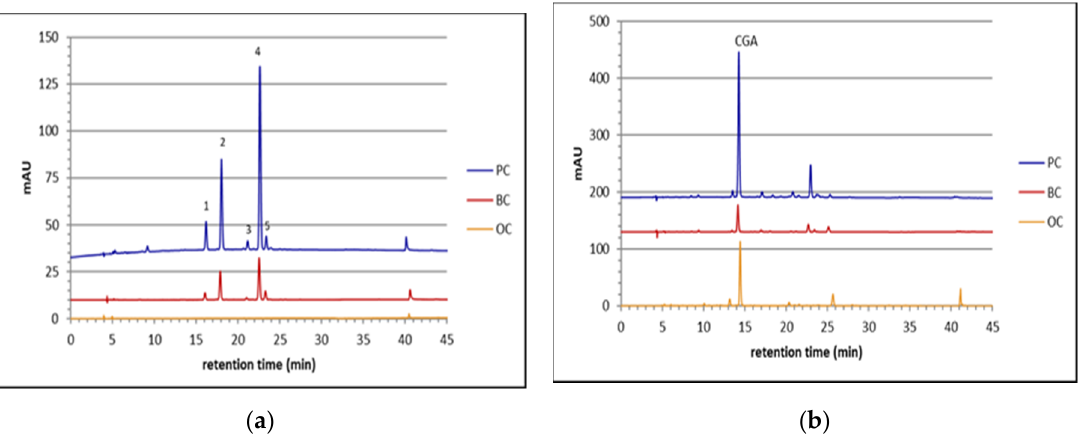
Figure 3. Chromatographic profiles of orange carrot (OC), BC and PC extracts at λ = 520 nm ( a ) and at λ = 320 nm ( b ). 1 : cyanidin 3-xylosyl (glucosyl) galactoside. 2 : cyanidin 3-xylosyl galactoside. 3 : sinapic acid derivative of cyanidin 3-xylosyl (glucosyl) galactoside. 4 : ferulic acid derivative of cyanidin 3-xylosyl (glucosyl) galactoside. 5 : coumaric acid derivative of cyanidin 3-xylosyl (glucosyl) galactoside. CGA : chlorogenic acid. BC extract was diluted by tenfold.